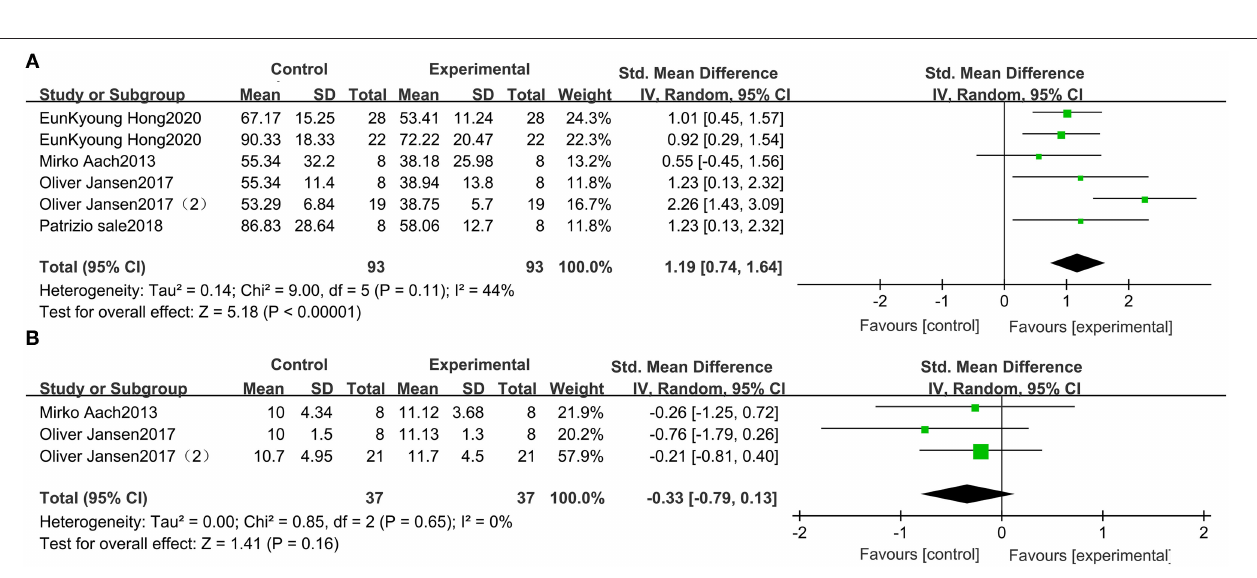
FIGURE 3 | Change from baseline in the distance traveled in the 10-MWT (A) , the speed traveled in the 10-MWT (B) and the distance traveled in the 6-MWT (C) .